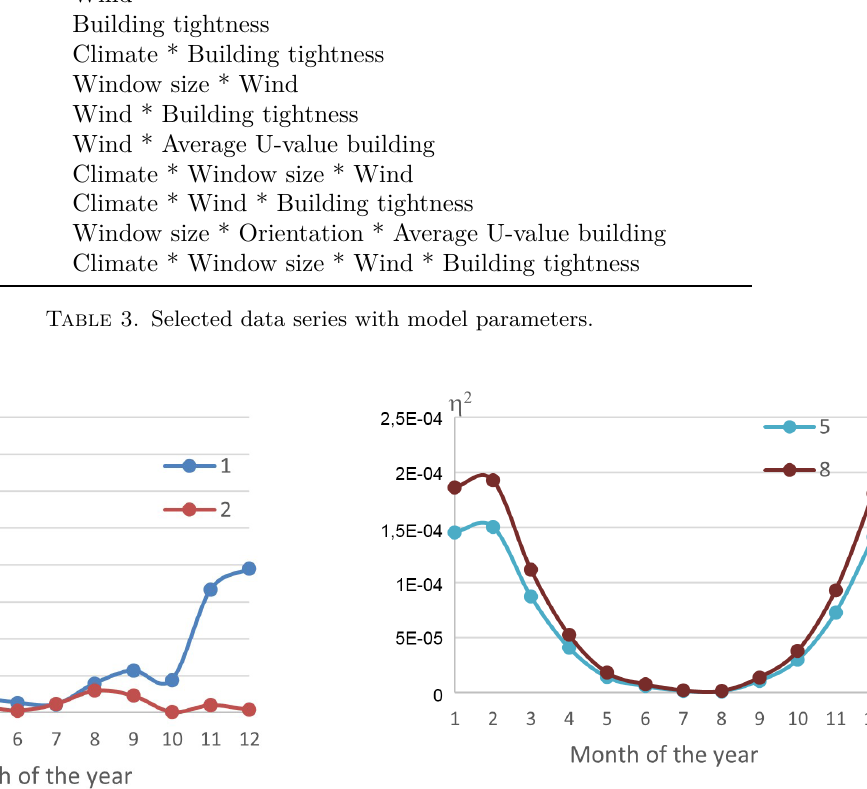
Figure 3. Influence of data series 5 and 8 over the year.